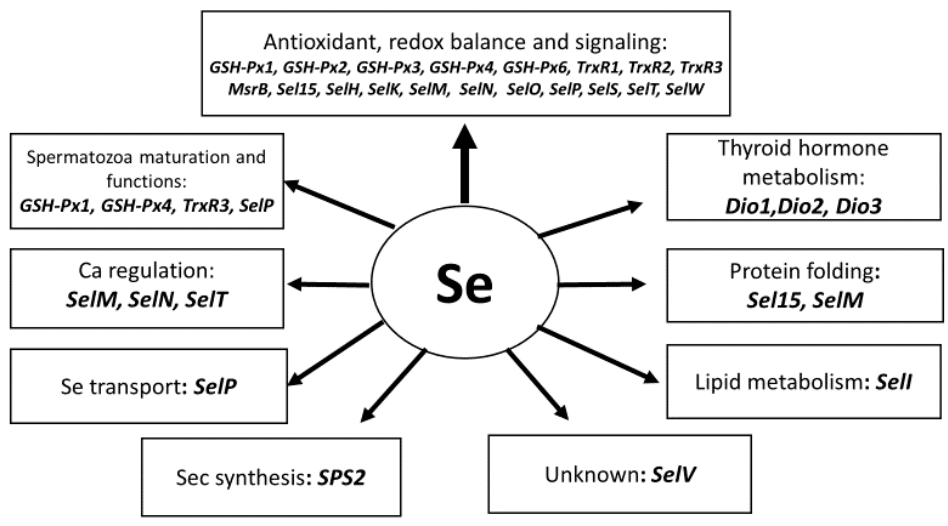
Figure 2. Selenoprotein functions in animals (adapted from [6,103]).